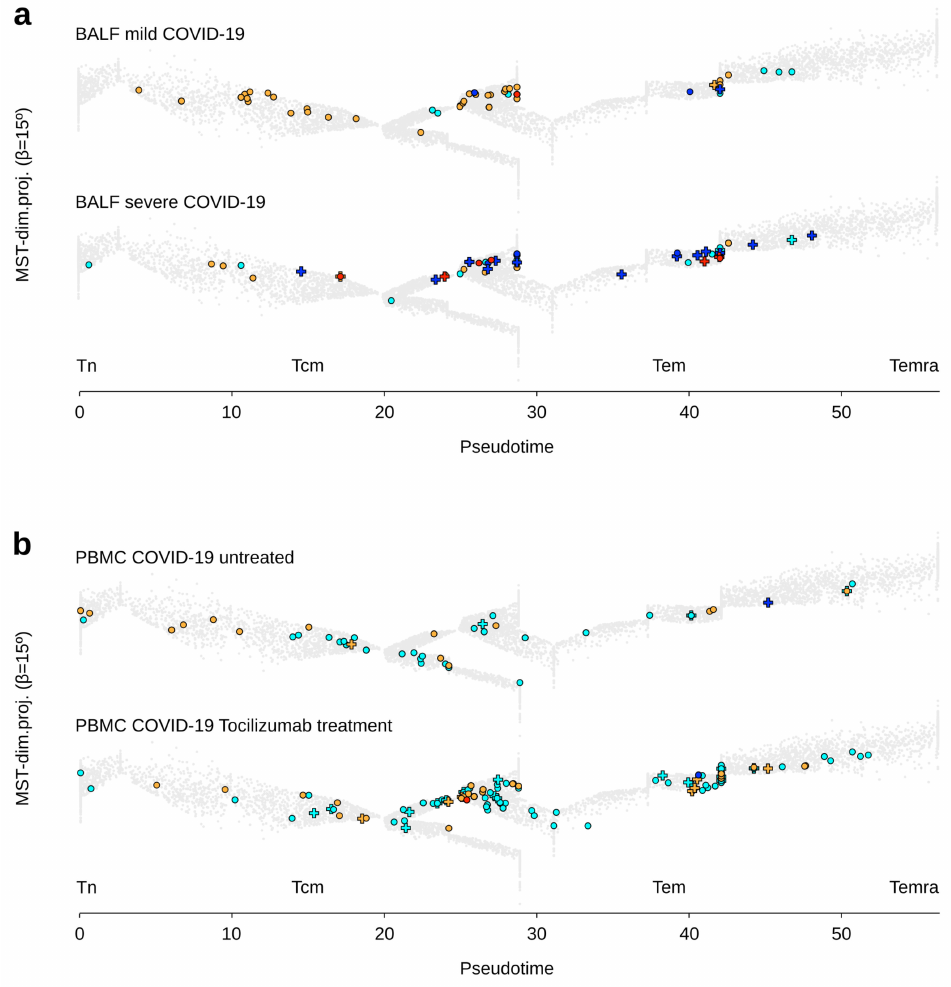
Figure 3. Differentiation and functional hallmarks of γδ T lymphocytes from adult COVID-19 patients. ( a ) BALF-derived γδ T lymphocytes from adult patients with mild or severe COVID-19 disease. ( b ) PBMC-derived γδ T lymphocytes from adult COVID-19 patients untreated or treated with Tocilizumab. (Representative examples overlaid on the public trajectory of γδ T lymphocyte differentiation, same legend key as in Figure